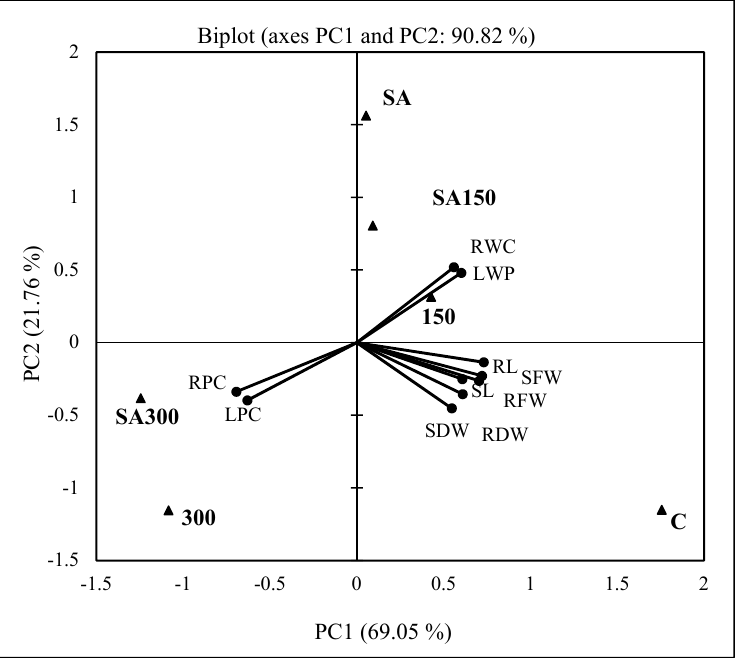
Figure 5. Bi − plot (PC1 × PC2) of PCA scores and loadings for shoot and root lengths (SL and RL), fresh and dry weights (SFW and SDW, RFW and RDW), leaf water potential (LWP) and relative water content (LRWC), and leaf and root proline contents (LPC and RPC). C; control, 150; 150 mM NaCl, 300; 300 mM NaCl, SA; 0.5 mM SA, SA150; 150 mM NaCl + 0.5 mM SA, SA300; 300 mM NaCl + 0.5 mM SA; RL, root length; SL, shoot length; RFW, root fresh weight; RDW, root dry weight; SDW, shoot dry weight; LRWC, leaf relative water content; LWP, leaf water potential; LPC, leaf proline content; RPC, root proline content. • Variables and 25B2 observations. Values in bold are different from 0 with a significance level of α = 0.05. Correlation matrix (Pearson, r ) between growth parameters and stress treatments; RL → SL → RFW r = 0.926, 0.871, 0.973; SL → SFW r = 0.929; RFW → SFW-SDW r = 0.907, 0.952, 0.844; RDW → SDW r = 0.901; RWC → LWP → LPC → RPC r = 0.968, − 0.898, − 0.947; LWP → LPC − RPC r = − 0.961, − 0.970; LPC → RPC r = 0.939.